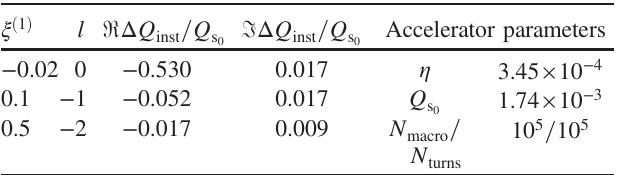
TABLE II. Simulation and accelerator parameters for the wakefield driven instability simulations. The coherent tune shifts are for the case with no Landau